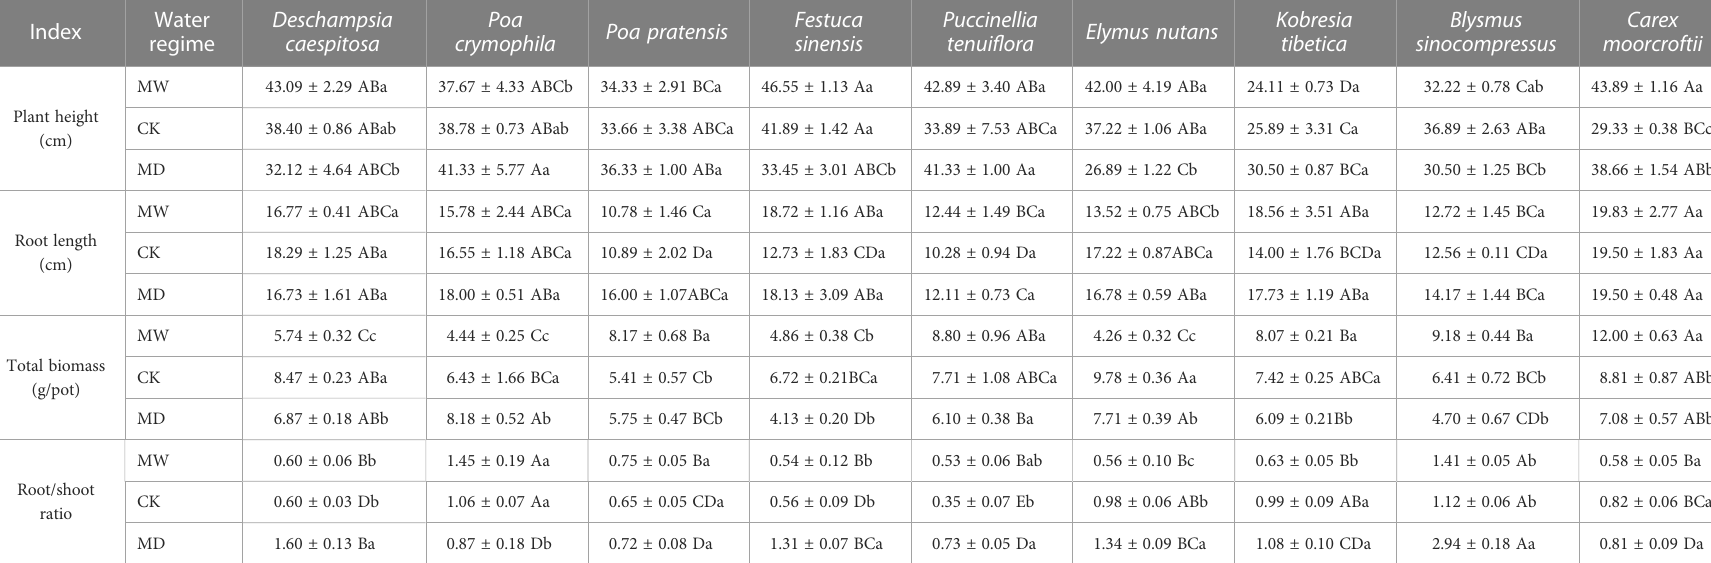
Different lowercase letters within the same row indicate that there are signi fi cant differences between water regimes for the same plant species at a =0.05; Different capital letters within the same column indicate that there are signi fi cant differences between plant species under the same water condition at a =0.05. Data are expressed as means ± SEM